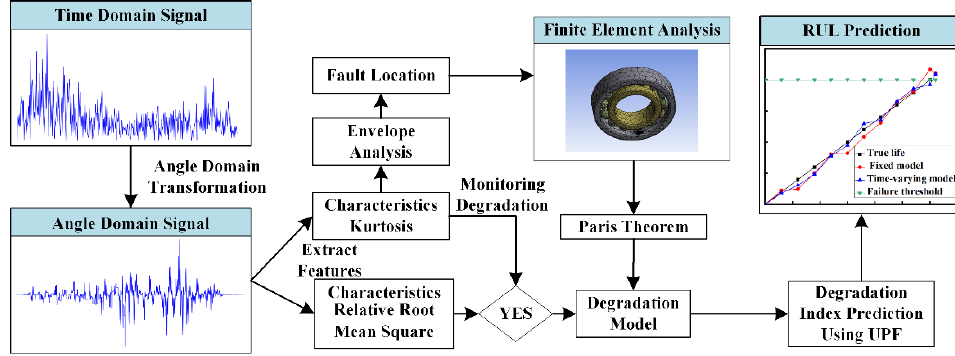
Figure 2. Bearing RUL prediction process using the present approach.